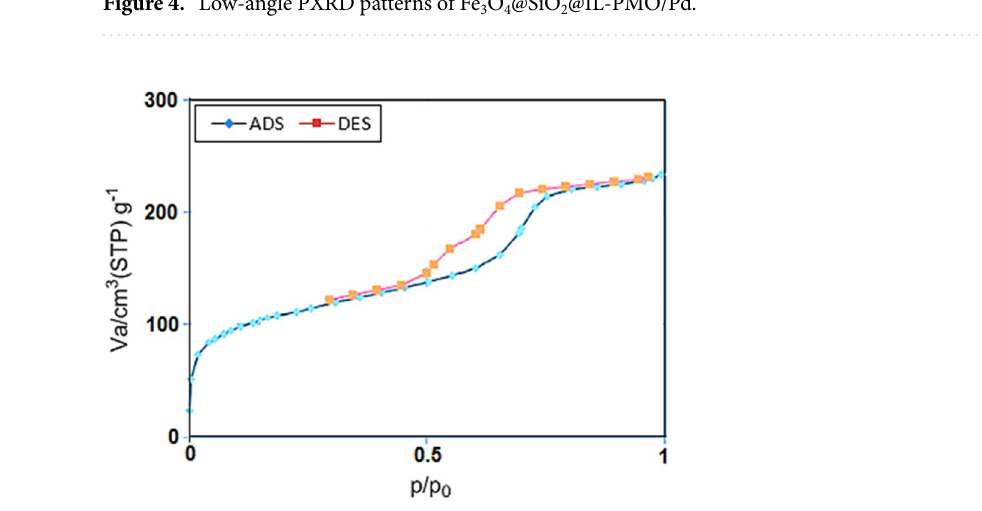
Figure 4. Low-angle PXRD patterns of Fe 3 O 4 @SiO 2 @IL-PMO/Pd.